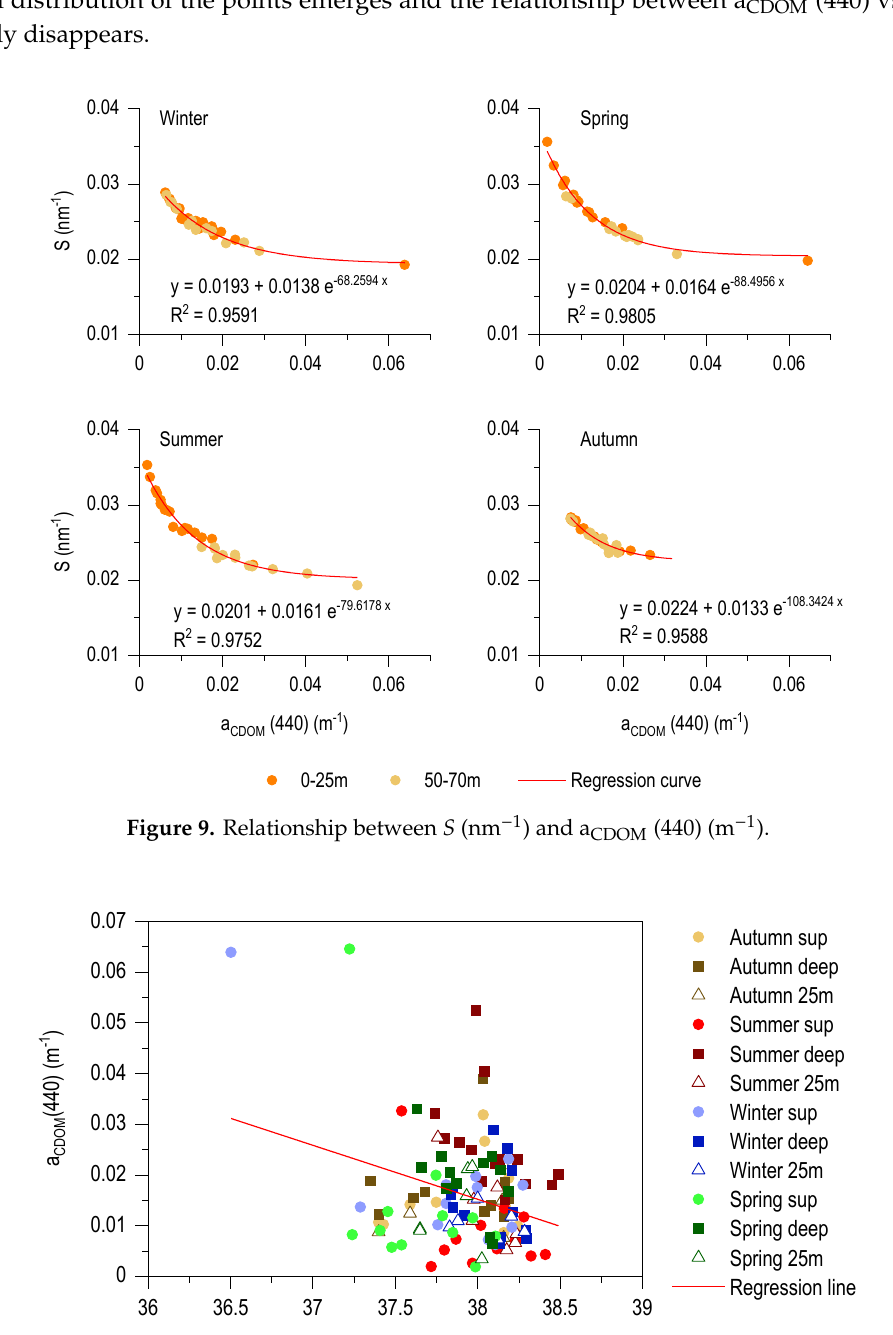
Figure 10. Relationship between a CDOM (440) (m −1 ) and salinity (‰).